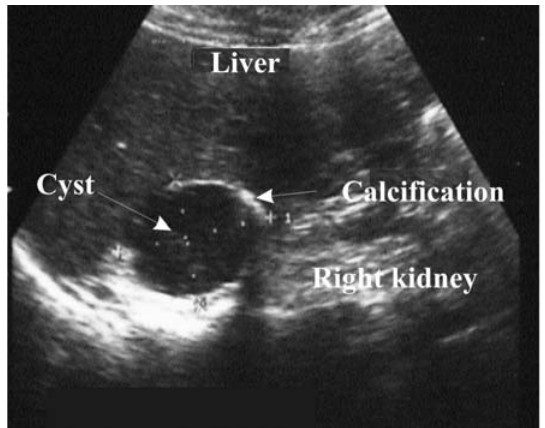
FIGURE 2 . Ultrasonographic image showing a well-circumscribed, proper-walled calcified mass of the right adrenal gland.